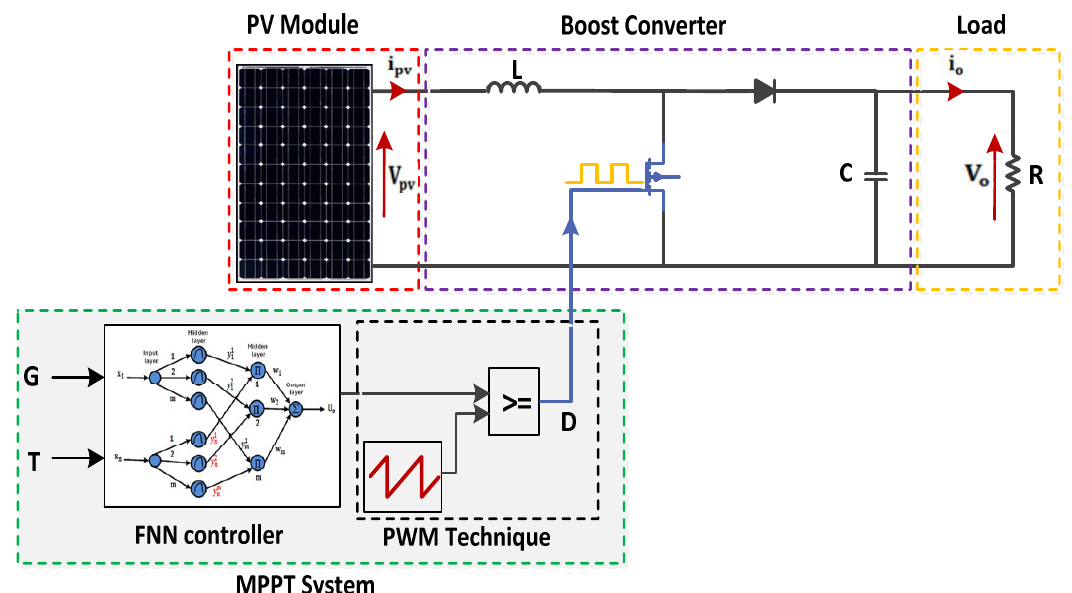
Figure 4. Block diagram of the PV system with an FNN controller based on MPPT.